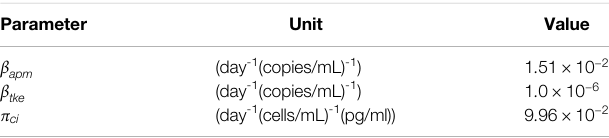
TABLE 6 | Model parameters values that fi t non-survivors data. All other model parameters values were those from Table 5 . Parameter Unit